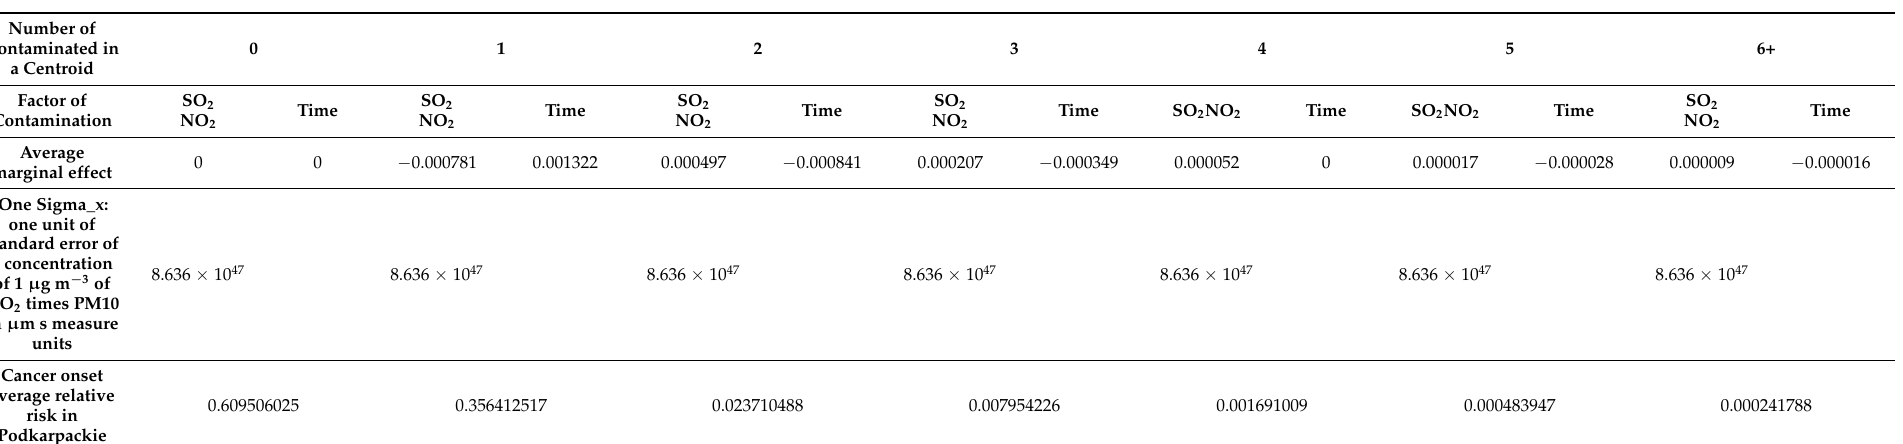
Table 7. Men squamous cancer: factors and